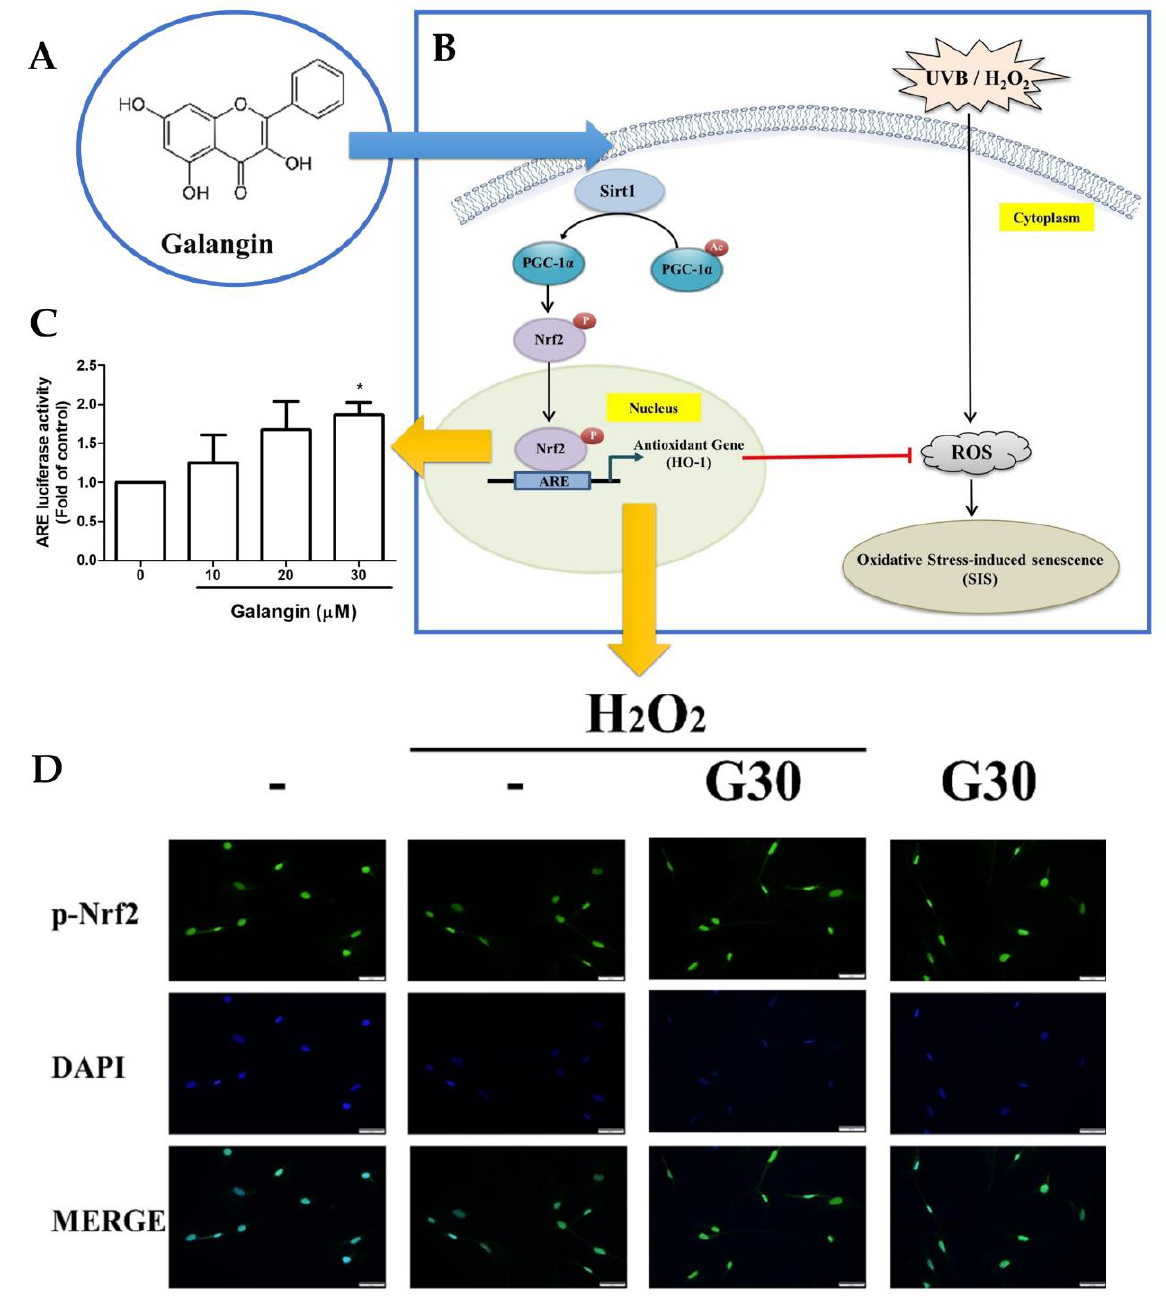
Figure 5. ( A , B ) Schematic representation of the effects of galangin on H 2 O 2 and UVB radiation- induced oxidative damage; ( C ) NRF2-dependent luciferase activity measurement results after treat- ment with galangin; ( D ) NRF2 nuclear translocation determination, acquired by fluorescence mi- croscopy; * p < 0.05; adapted from Lee et al. [31].